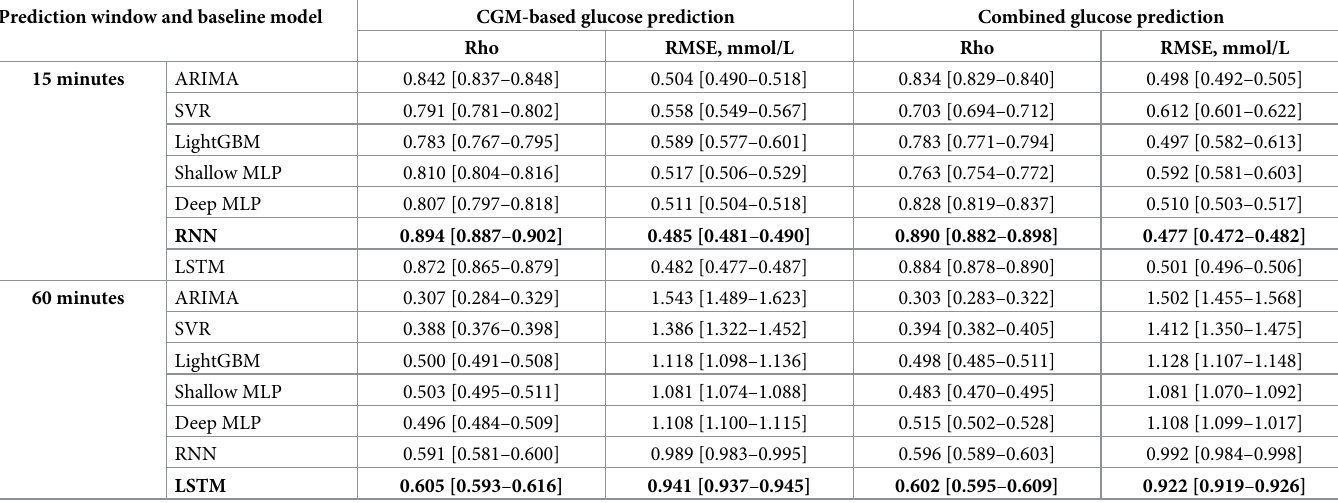
Table 1. Baseline statistical and machine learning model comparison for predicting glucose